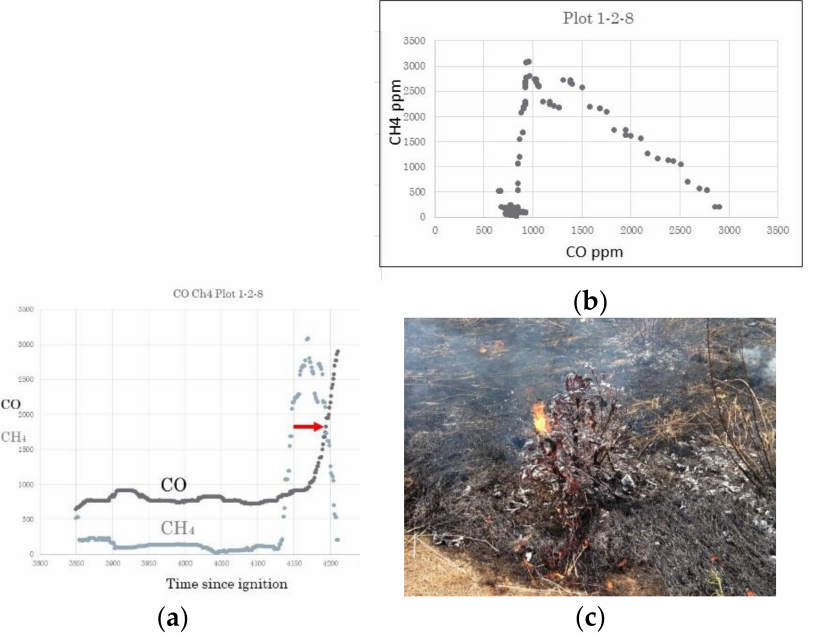
Figure 14. Relationship between CO and CH 4 emissions over time during a savanna fire in Mali with small trees. ( a ) Changes in CO and CH 4 emissions over time. ( b ) Changes in the CH 4 to CO ratio during the burning of a small tree. ( c ) Final stage of burning of a small tree; note that the flaming front has advanced well ahead in the